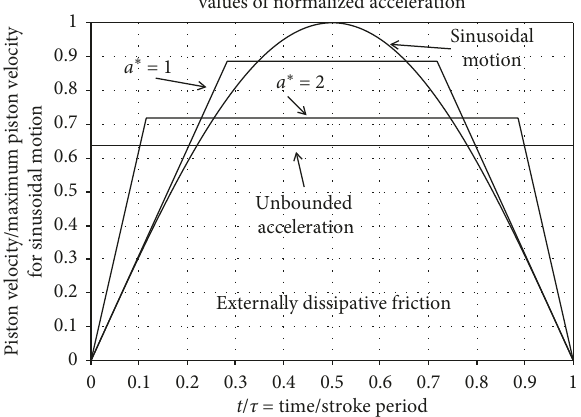
Figure 3: Piston velocity plotted against time, for one engine (expansion) stroke for (1) conventional sinusoidal motion; (2) optimal motion, externally dissipative friction, unbounded accel- eration; (3) optimal motion, externally dissipative friction, a ∗ � 2; (4) optimal motion, externally dissipative friction, a ∗ � 1. The abscissa is time divided by stroke time ( t / τ ), and the ordinate is piston velocity relative to its maximum value for the conventional trajectory. a ∗ � maximum piston acceleration relative to maximum piston acceleration for sinusoidal